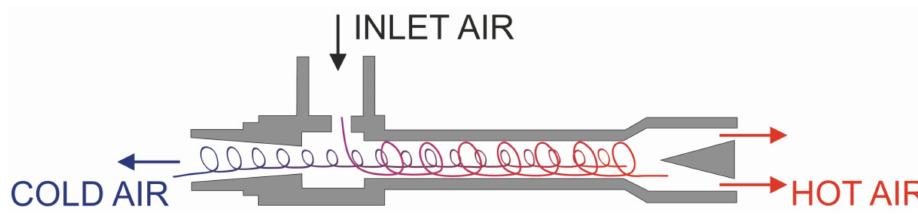
Figure 1. Schematic of a Ranque–Hilsch vortex